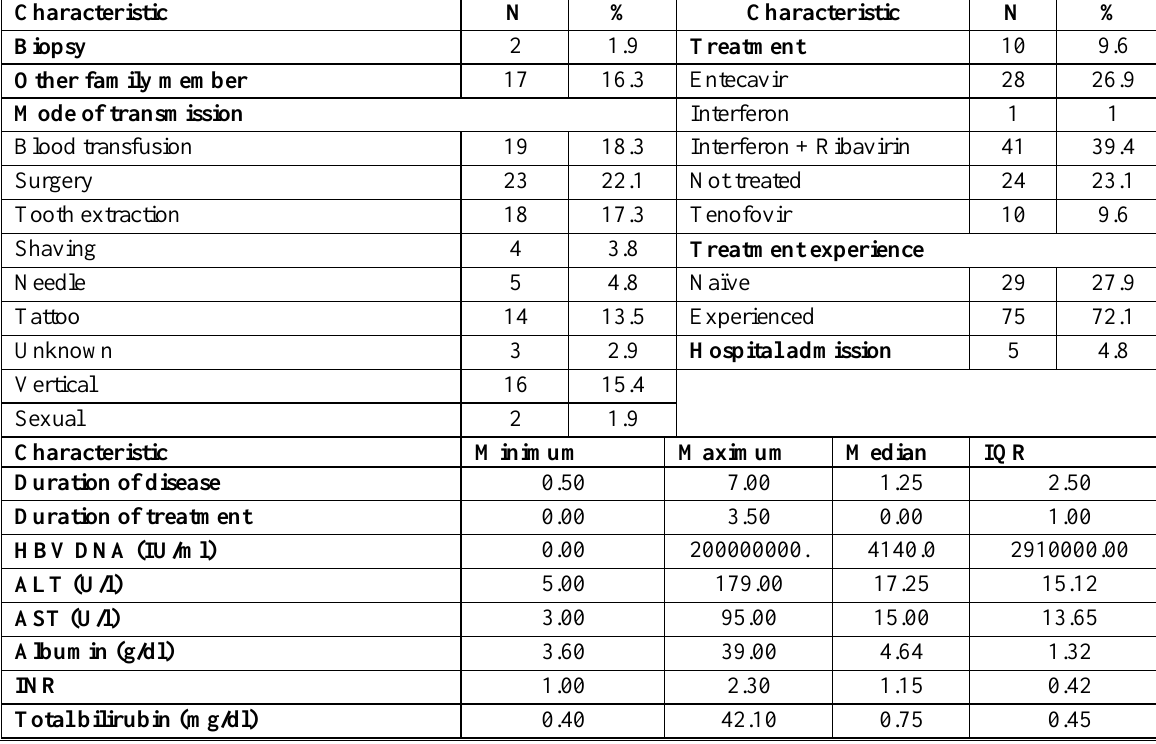
Table 2. Disease characteristics and investigations in patients with chronic hepatitis B infection .